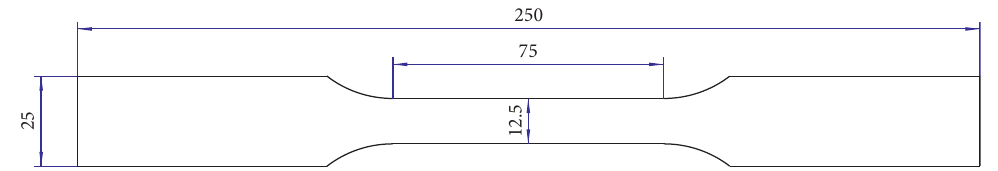
Figure 3: The drawing of tensile test specimen (unit: mm).